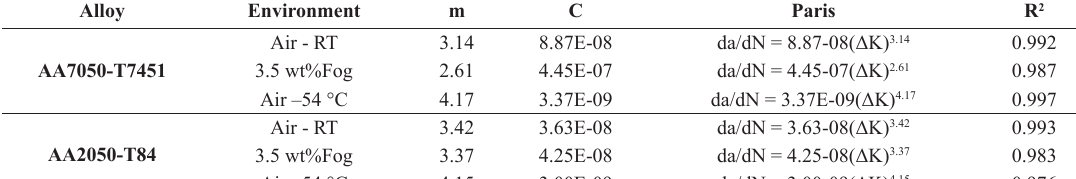
Table 2. Material´s constant C and m for the Paris-Erdogan equation. Alloy